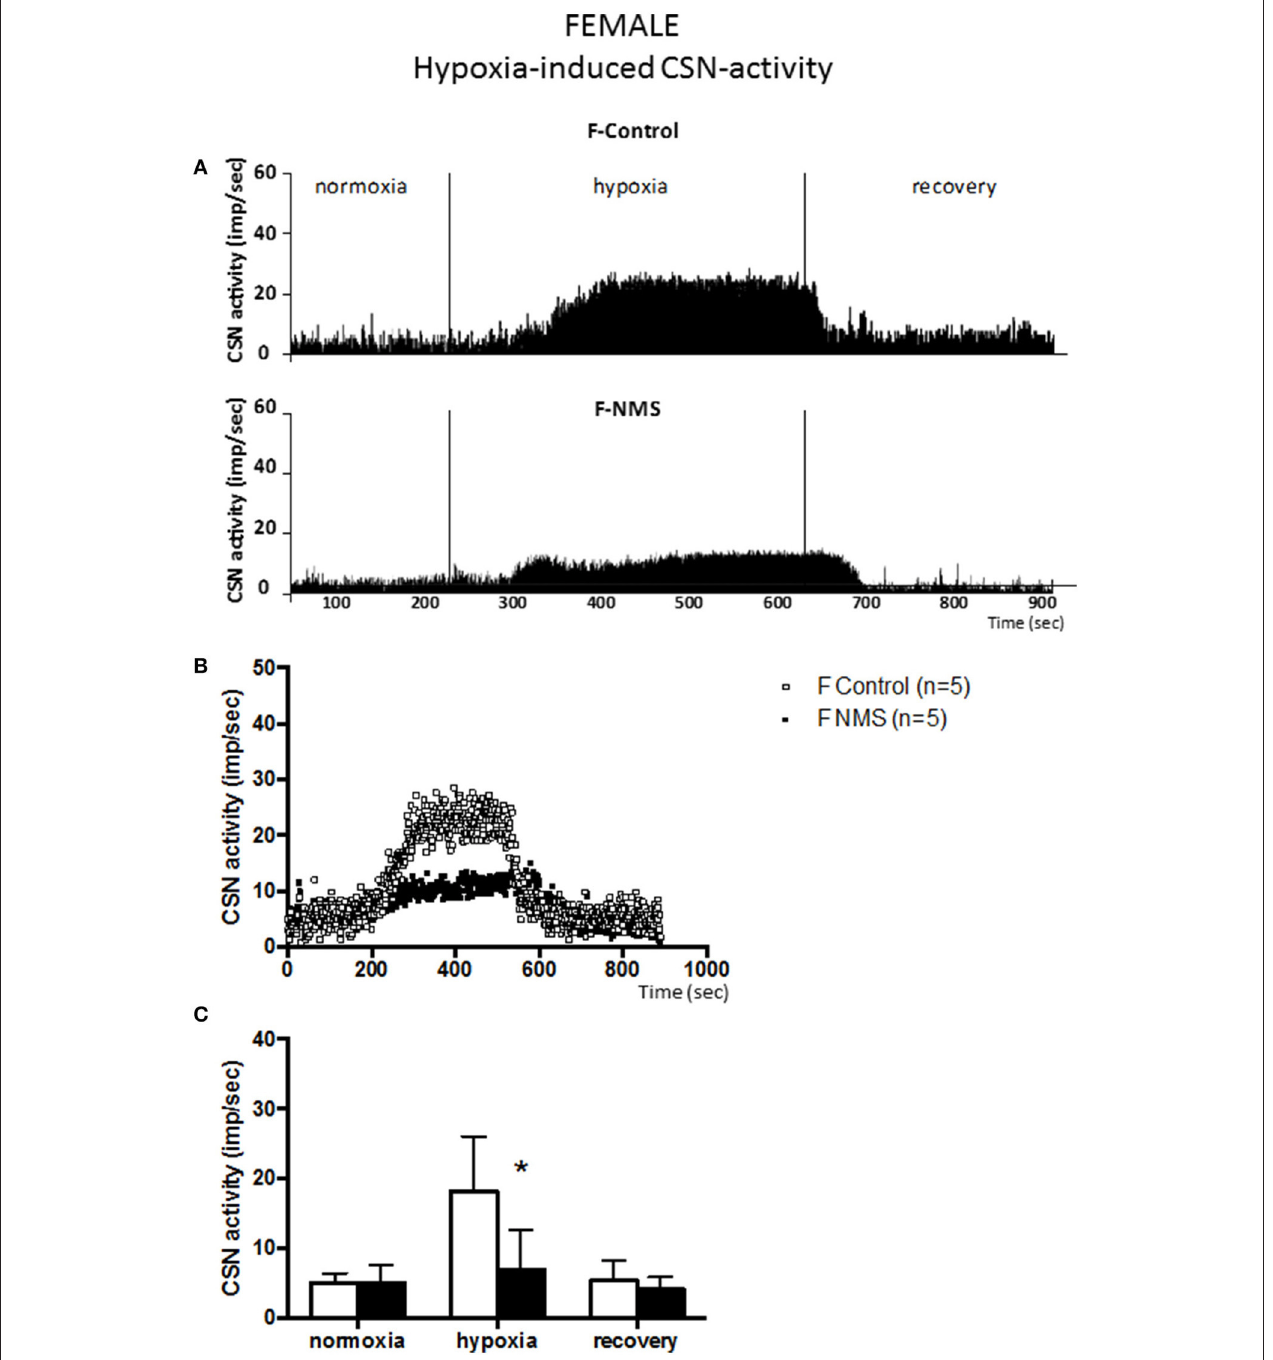
FIGURE 2 | Neonatal maternal separation (NMS) decreases carotid sinus nerve (CSN) response to hypoxia in female rats. (A) Original recordings comparing CSN activity from ex vivo preparations of perfused carotid body/CSN from control and NMS females under hyperoxia (FiO 2 = 0.95), hypoxia (FiO 2 = 0.0) and hyperoxia after hypoxia (recovery). (B) Comparison of the mean carotid sinus nerve activity (imp/sec) over the course of the hypoxic protocol between carotid bodies from control (open squares; n = 5) and NMS rats (black squares; n = 5). Hypoxia begins at T = 0 and is maintained until T = 500s (end of plateau phase), followed by hyperoxic recovery; each data point represents the mean value on a second by second basis. (C) Histograms comparing mean CSN activity for each specific experimental condition between control (white bars; n = 5) and NMS (black bars; n = 5) female rats. Data are reported as means ± SD . *Indicates a value statistically different from control at p ≤